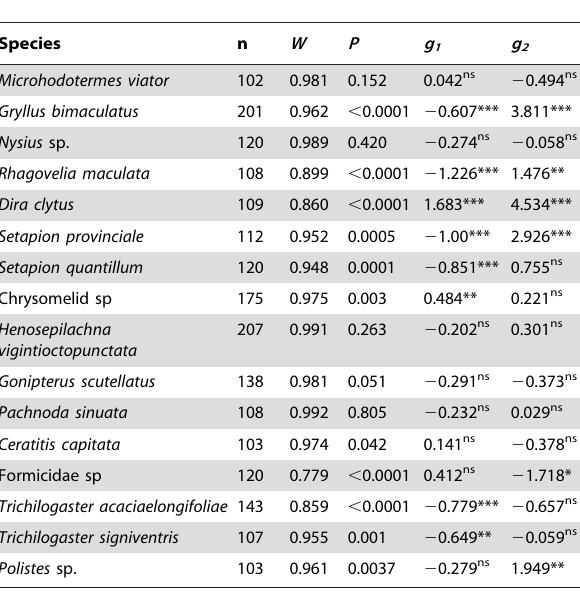
Table 3. Outcome of the assessment of deviation from normality (Shapiro-Wilks W statistic) and the degree of skewness ( g 1 ) and kurtosis ( g 2 ) for the log transformed body mass frequency distributions of all 16 insect species